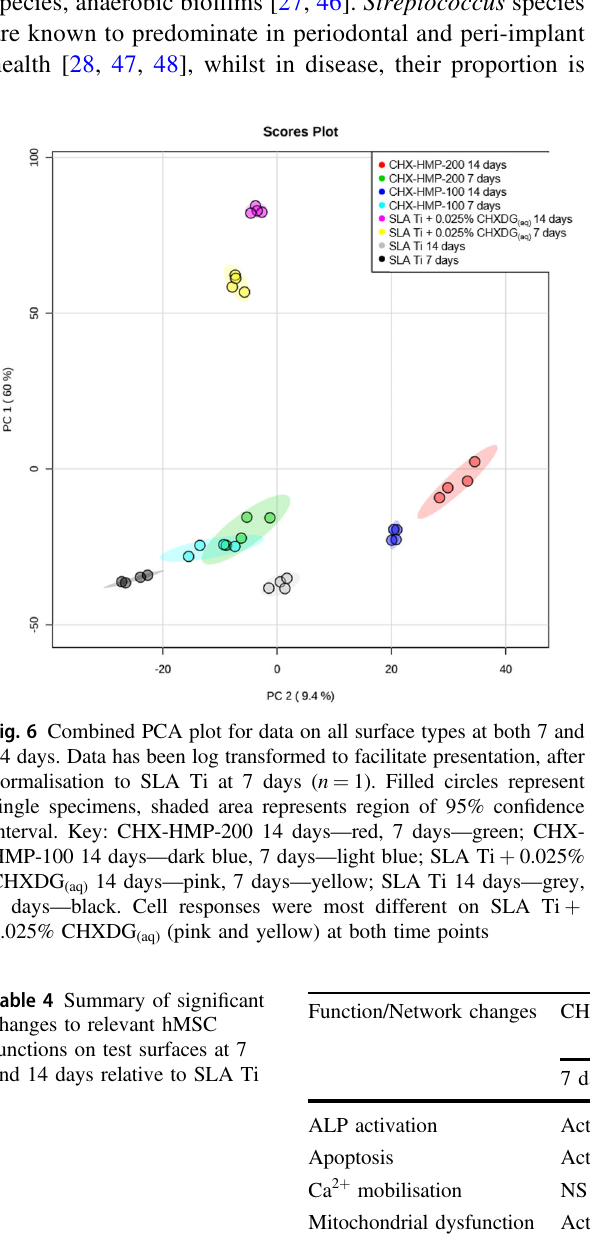
are shown. NS — no signi fi cant difference compared to SLA Ti control at same time point. Results are predicted changes to functional networks, based on z -scores from metabolomic analysis (Supplementary Data 9)